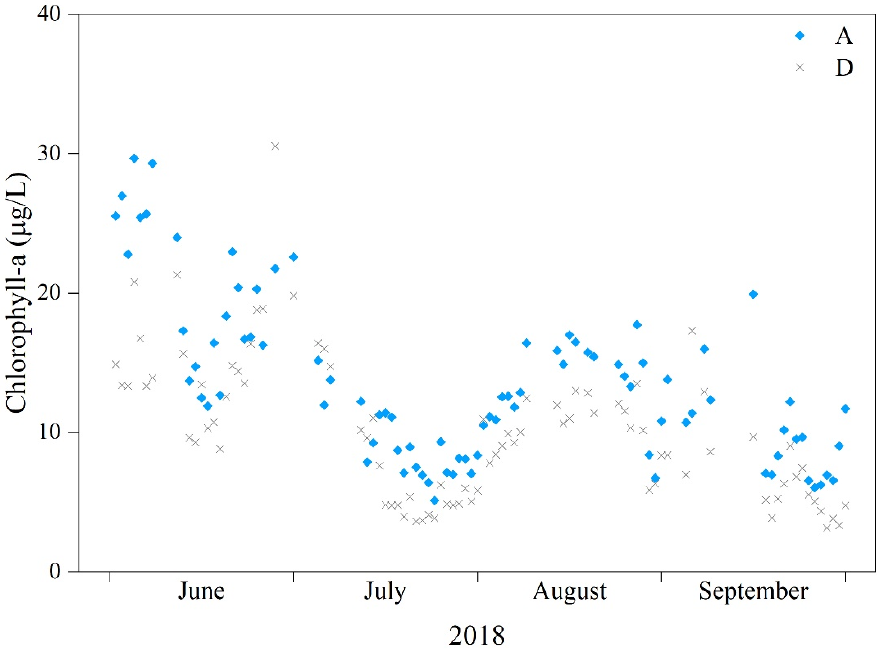
Figure 6. Changes in chlorophyll-a values in 2018 at (A) the CWCS deployment site and (D) the natural circulation site (200 m away from site